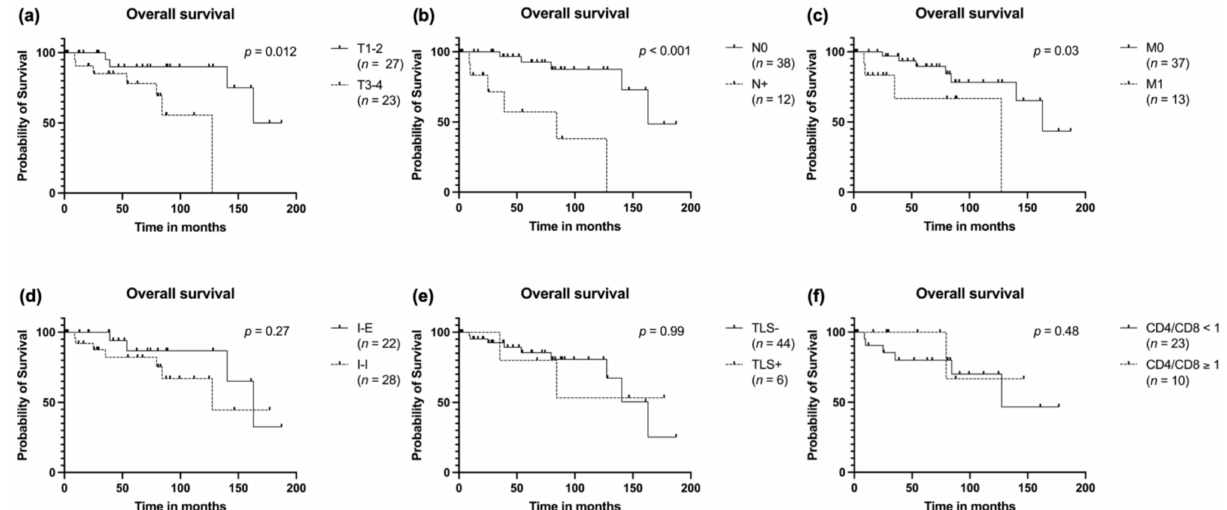
Figure 4. Overall survival stratified to ( a ) T stage, ( b ) N stage, ( c ) distant metastasis, ( d ) spatial distribution of TIL, ( e ) presence of TLS in the primary tumor and ( f ) CD4/CD8 T cell ratio.